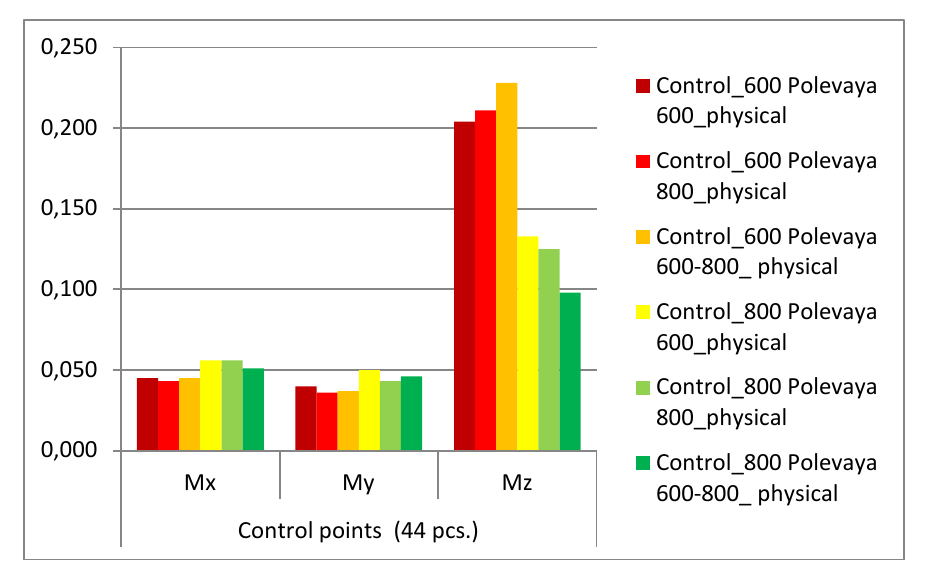
Table 2. The results of the estimation of the accuracy of the triangulation by PhotoScan